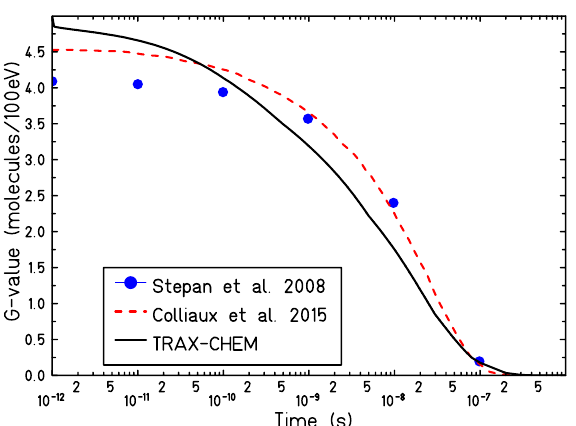
Figure 2. Comparison of different time dependent calculated yield for e − aq produced by irradiation with 5 MeV protons in a target with a partial oxygen pressure in air of 21%. —— : TRAX-CHEM, – – – : Colliaux et al. [15], • : Štepán and Davídková